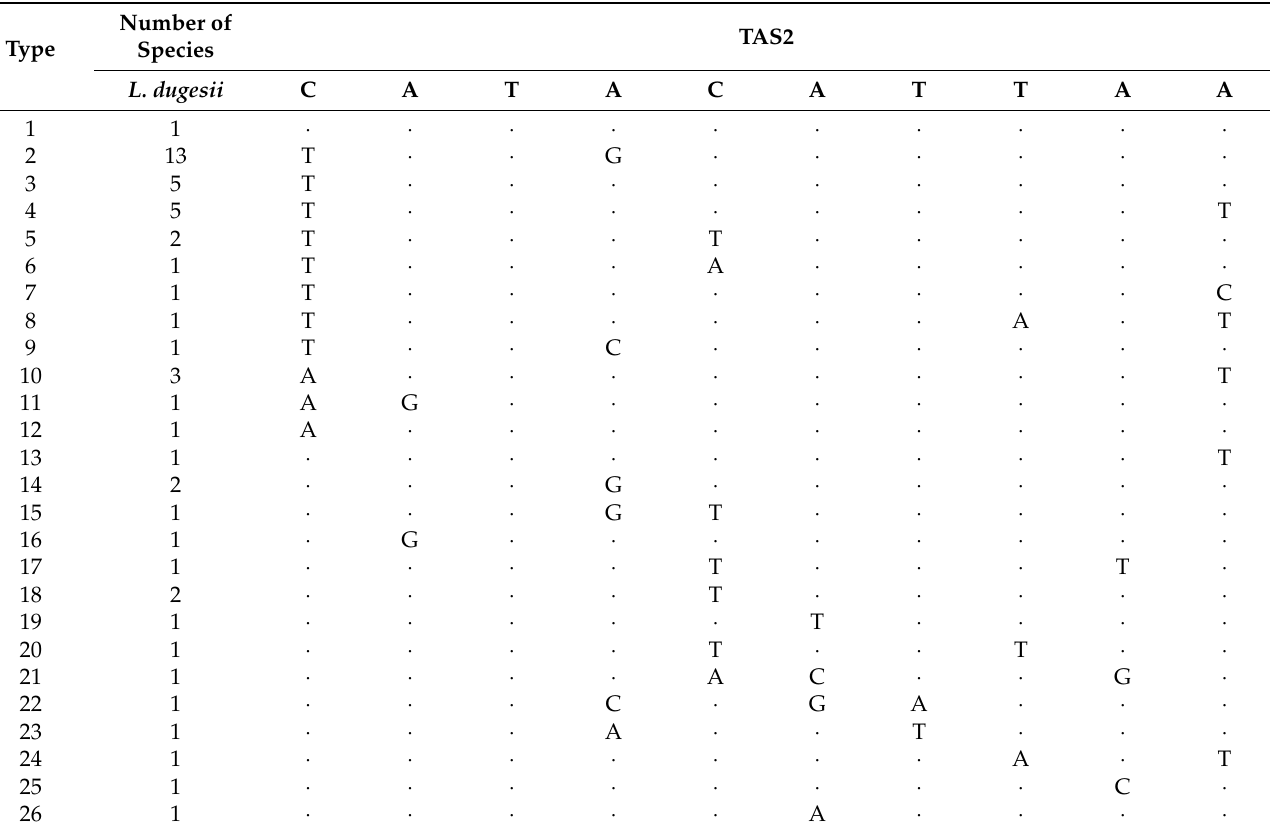
Table 6. Type of conserved structure element of TAS2 in